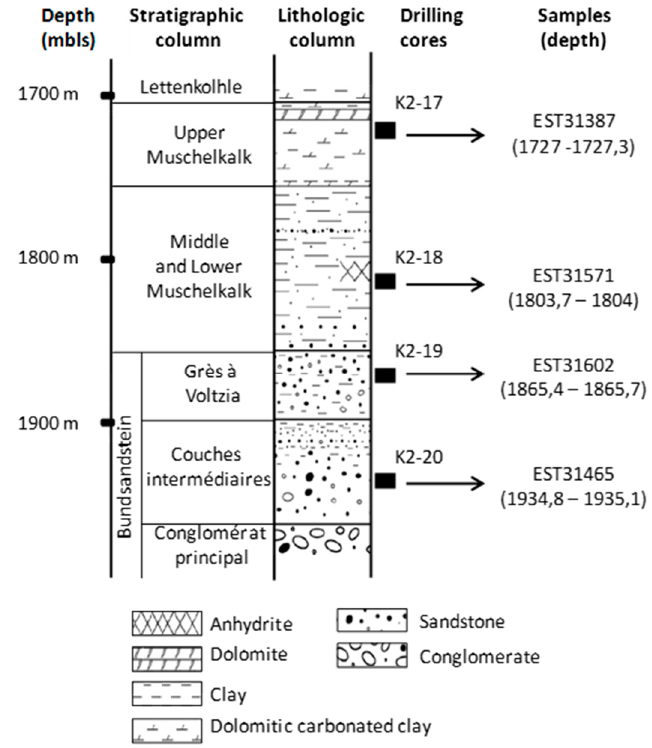
Figure 2. Location of drilling cores and samples from the EST433 deep borehole (Paris Basin, France) into the lithostratigraphic column.